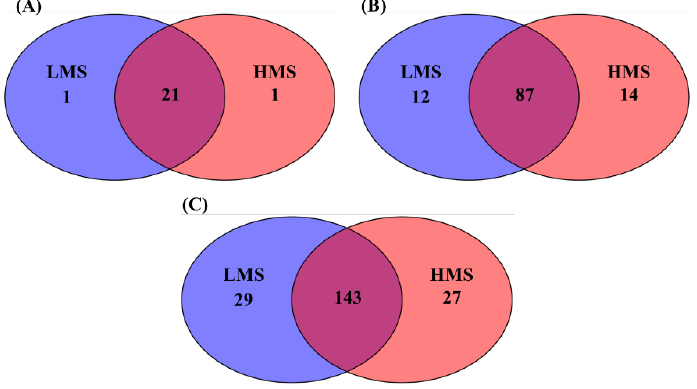
Figure 2. The number of shared and exclusively identified taxa in collapsed ( A ) phyla, ( B ) families, and ( C ) genera BIOM tables between low marbling score (LMS) and high marbling score (HMS) groups.